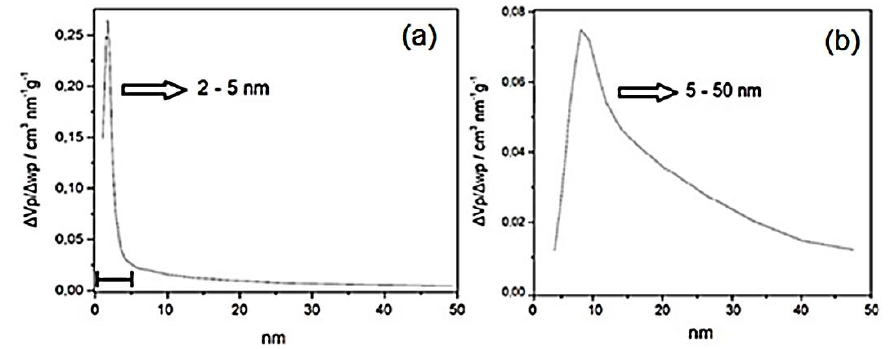
Figure 5. Pore volume distribution for bimodal silica in the range of 2–5 nm ( a ) and 5–50 nm ( b ).